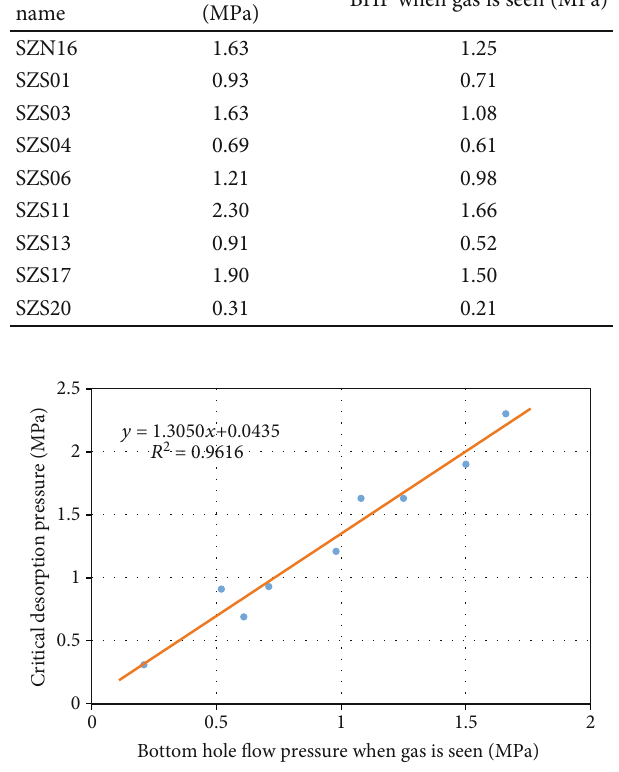
Figure 7: Relationship between critical desorption pressure and bottom hole pressure at begin of gas fl